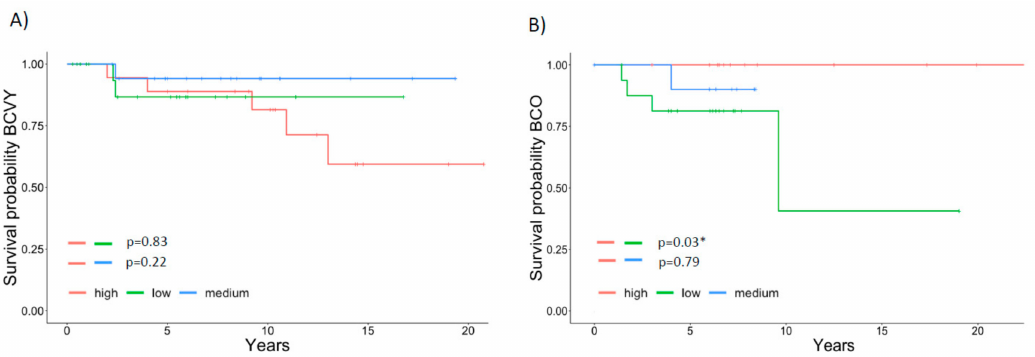
Figure 2. Association of HDAC5 expression and survival in breast cancer patients. Survival curves for HDAC5 expression in BCVY (n = 42) ( A ) and BCO patients (n = 28) ( B ). HDAC5 expression was classified in high (red), medium (blue) or low (green). BCVY: Breast cancer in very young women; BCO: Breast cancer in old women. * p ≤